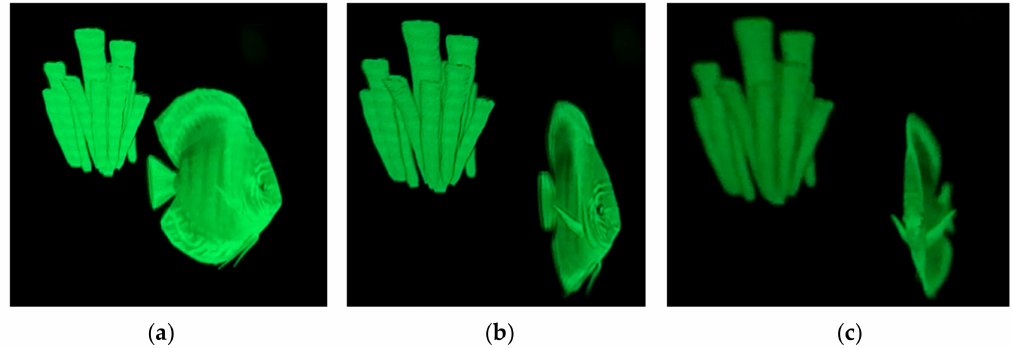
Figure 8. Optical reconstructions of second 3D animation model. ( a ) Both in focus; ( b ) Coral in focus; ( c ) Fish in